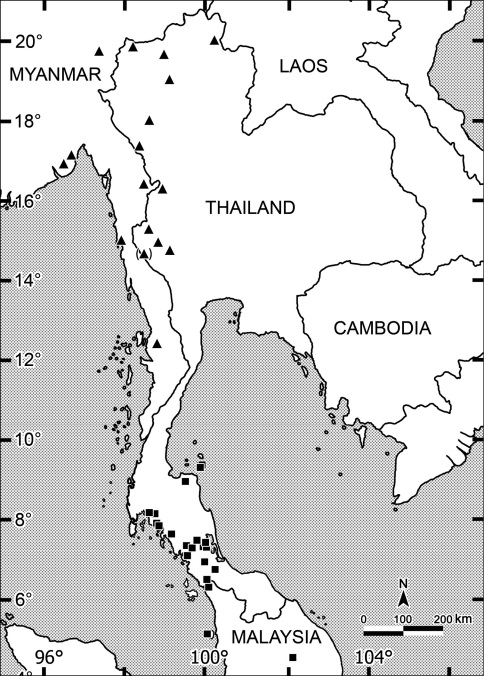
Distribution of two widespread species of Orthomorpha. Filled square: Orthomorpha lauta Golovatch, 1998; Filled triangle: Orthomorpha insularis Pocock, 1895.